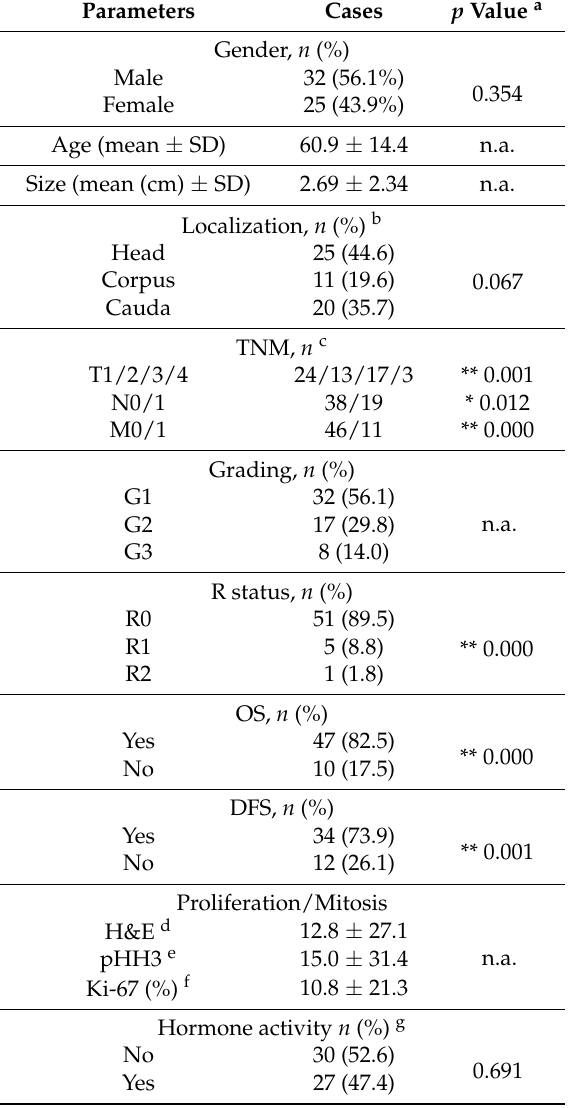
Table 1. Patient characteristics of pancreatic neuroendocrine tumors